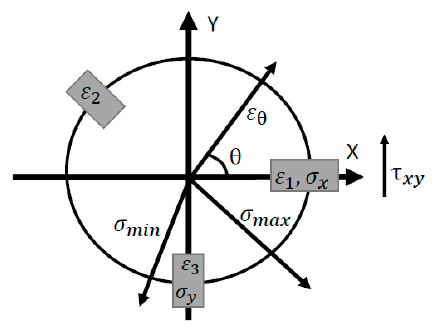
Figure 1. Typical geometry of a clockwise strain gauge and the coordinate system used.